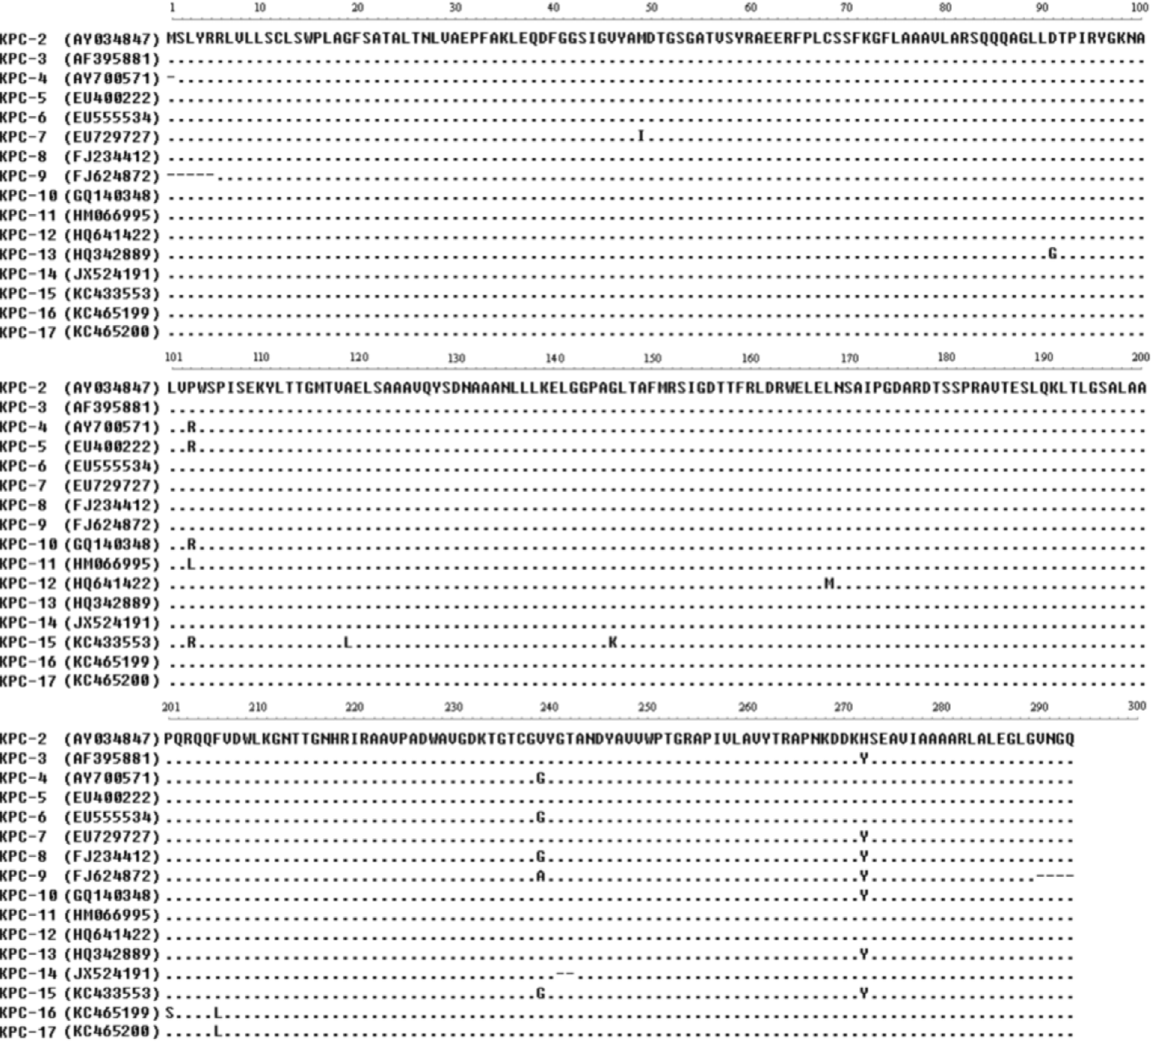
Figure 1. Comparison of amino acid sequence alignments of KPC carbapenemases. KPC-15 was recently identified as a carbapenemase in Klebsiella pneumonae from the Taizhou Municipal Hospital of China. The data within parentheses are GenBank accession numbers.